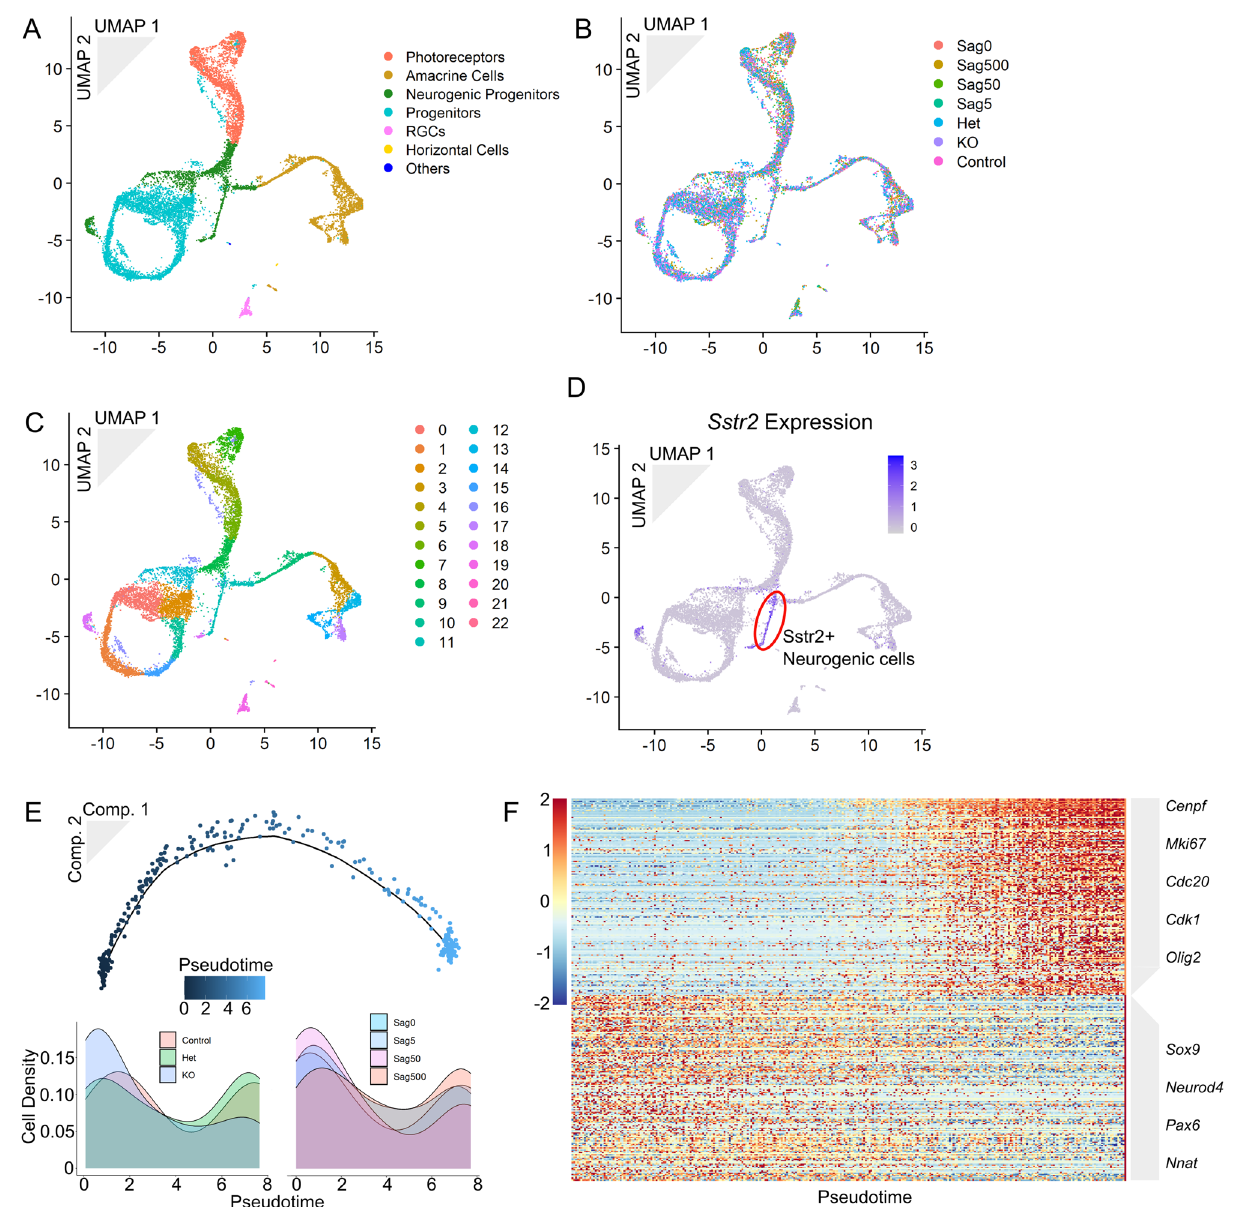
Figure 5. Integrated dataset of explant and retina cells reveals shared genetic changes. The explant and P0 datasets were integrated following the Seurat protocol. n = 11,313 cells. ( A ) 2D UMAP dimension reduction representation of the integrated datasets colored by identified cell type. ( B ) Cells colored by genotype or treatment condition. ( C ) Cells colored by Seurat-identified cluster. ( D ) Cells colored by Sstr2 expression. ( E ) Monocle-generated trajectory of Sstr2 -expressing neurogenic cells from cluster 11 (top). Density plot for cells of each in vivo genotype aligned along pseudotime (bottom left). Density plot for cells of each ex vivo treatment aligned along pseudotime (bottom left). ( F ) Heatmap of two clusters of genes that either increase with pseudotime (top 170 genes) or decrease with pseudotime (bottom 161 genes). Genes identified with Monocle 2 function ‘differentialGeneTest()’, q-value cutoff 0.05. Genes clustered by k-means (seed =